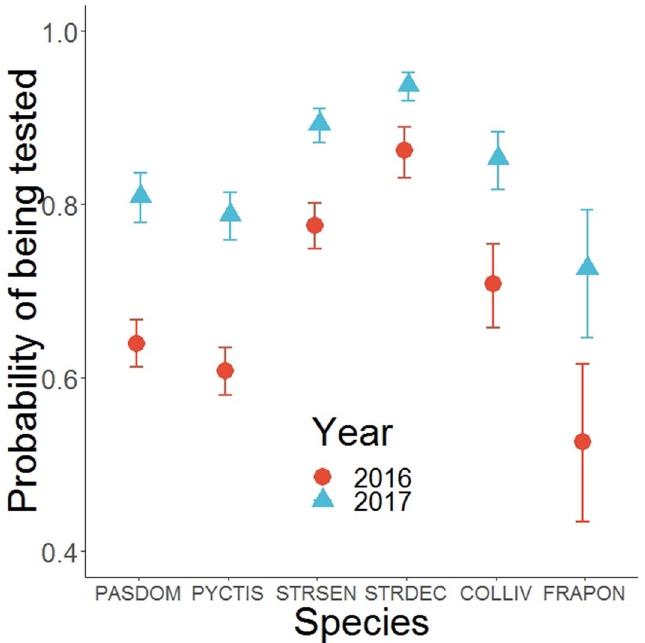
Figure 7. Probabilities of being tested for each bird species according to the year of sampling. PASDOM stands for Passer domesticus , PYCTIS for Pycnonotus leucotis , STRSEN for Spilopelia senegalensis , STRDEC for Streptopelia decaocto , COLLIV for Columba livia and FRAPON for Francolinus pondicerianus. Error bars represent 95% confidence